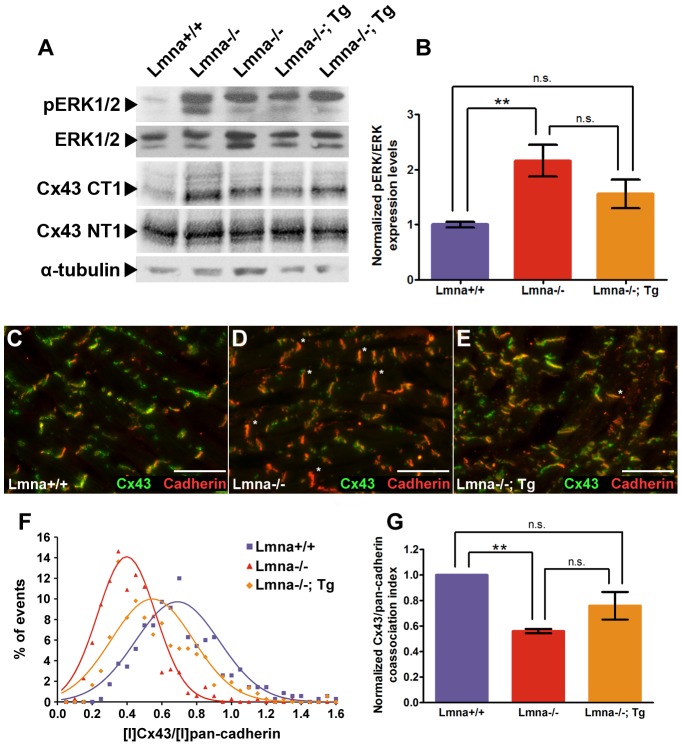
Transgenic expression of lamin A in Lmna
−/− cardiomyocytes partially restores ERK1/2 activation and gap junction protein localization.(A) Western blot analysis of Lmna
+/+, Lmna
−/−, and Lmna
−/−; Tg mouse heart lysates. Phosphorylated-ERK1/2 (pERK1/2) levels are increased in Lmna
−/− compared to Lmna
+/+ and are decreased in Lmna
−/−; Tg hearts while total ERK1/2 levels are unchanged. Total Cx43 protein levels detected by NT1 are unchanged, while cytoplasmic levels of Cx43 as detected by CT1 are increased. α-tubulin is shown as a loading control. (B) Quantification of pERK1/2 levels normalized to total ERK1/2 levels in 5–7 week old Lmna
+/+ (N = 13), Lmna
−/− (N = 16), and Lmna
−/−; Tg (N = 11) mouse heart lysates. One-way ANOVA analyses were performed for significance with post-test significance values as follows: ** P<0.01; n.s. not significant. (C–E) Indirect immunofluorescence micrographs of pan-cadherin (red) and Cx43 (green) in Lmna
+/+ (C), Lmna
−/− (D), and (E) Lmna
−/−; Tg heart ventricle sections taken at equivalent exposure times from 6-week old mice. Asterisks mark intercalated discs with qualitative decreases in Cx43 relative to pan-cadherin staining. White scale bar denotes 50 µm. (F) Distribution of individual intercalated disks summarizing relative frequency of Cx43 co-association index in 5–7-week old Lmna
+/+ (N = 3; 350 intercalated discs analyzed total), Lmna
−/− (N = 3; 349 intercalated discs analyzed total), and Lmna
−/−; Tg (N = 3; 367 intercalated discs analyzed total) mice. A non-linear regression for Gaussian distribution was fitted for each group tested (Lmna
+/+ R2 = 0.91; Lmna
−/− R2 = 0.96; Lmna
−/−; Tg R2 = 0.80). (G) Combined Cx43 co-association indices from multiple experiments normalized against their respective Lmna
+/+ control (N = 3). One-way ANOVA analyses were performed for significance with post-test significance values as follows: ** P<0.01; n.s. not significant.